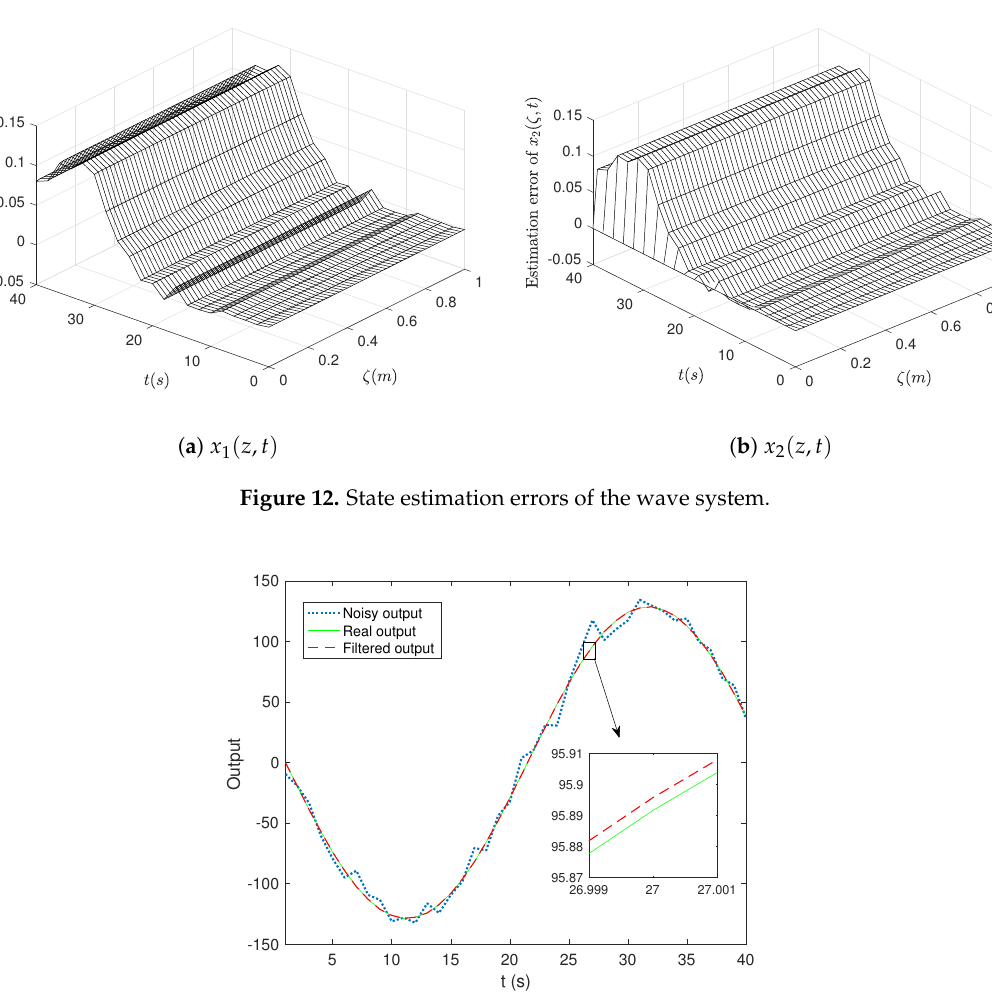
Figure 13. Output filtering performance of the wave